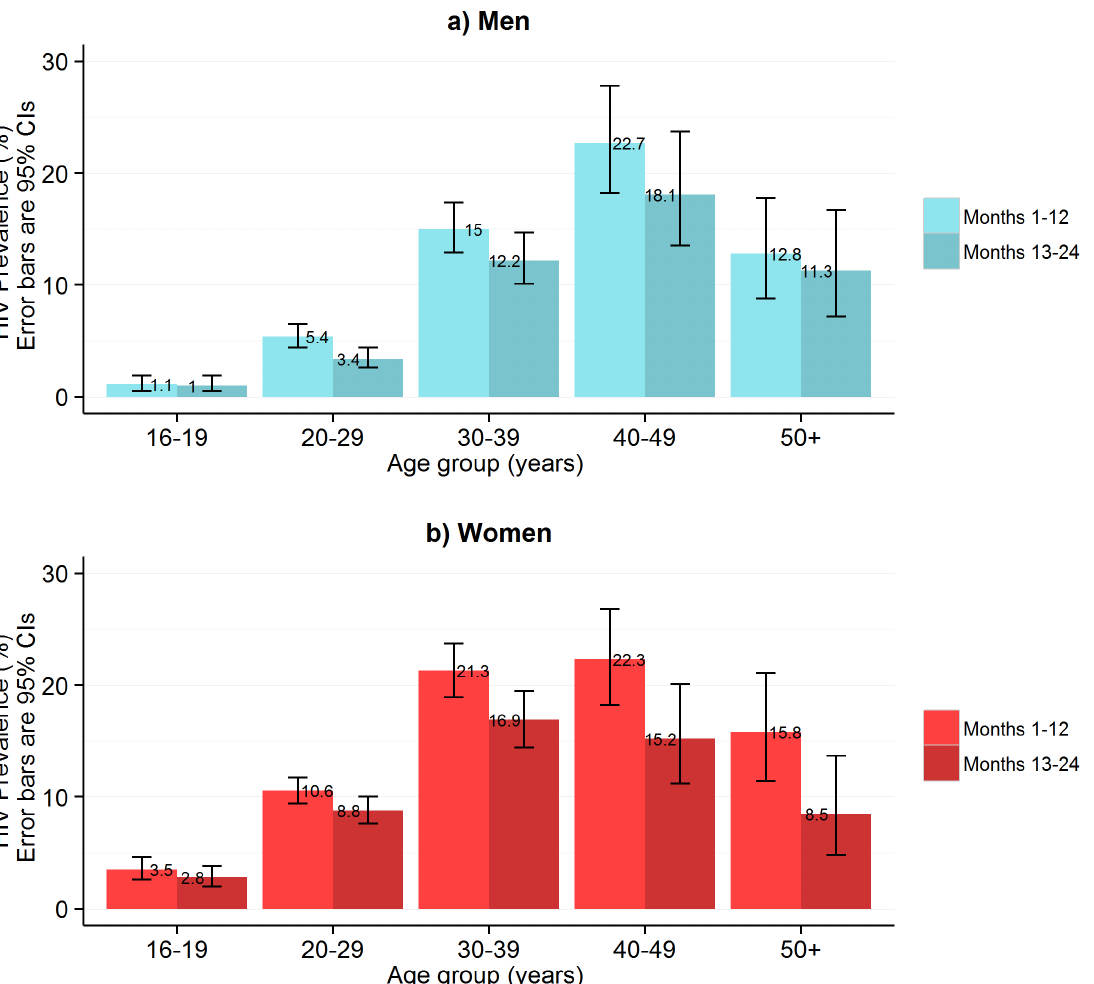
Fig 4. HIV prevalence in self-testing participants who returned used test kits by sex and age group and time of HIV self-testing availability. This figure shows HIV prevalence in HIVST participants for men (A) and women (B), stratified by time of HIVST availability. Bars show HIV prevalence (percent); error bars show 95% confidence intervals. Estimates are based on denominators determined through enumeration. Numerators were based on a reread of used and returned HIVST kits by a laboratory technician within 2 wk of use. Individuals were asked to test only once within each 12-mo time period, and retesting in people already aware of their positive HIV status was